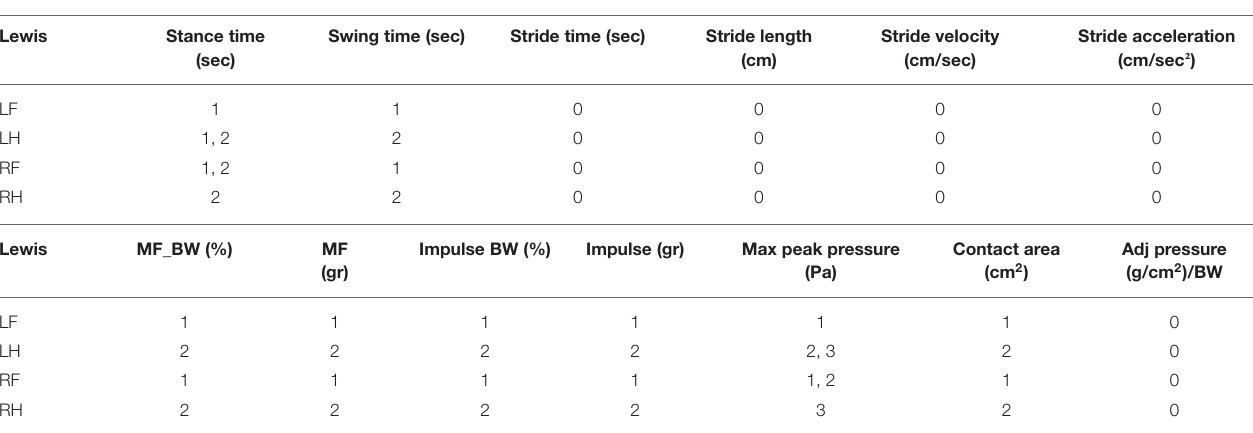
TABLE 5 | Lewis mean value group comparison between limbs.